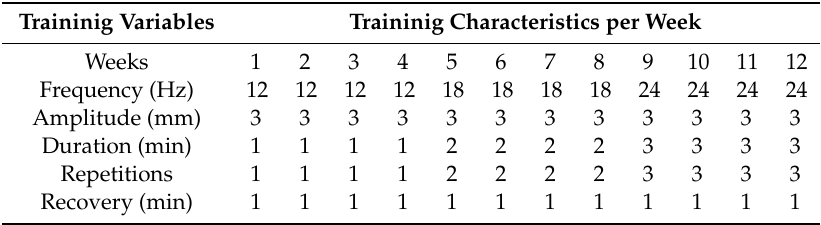
Table 1. The Whole Body Vibration training